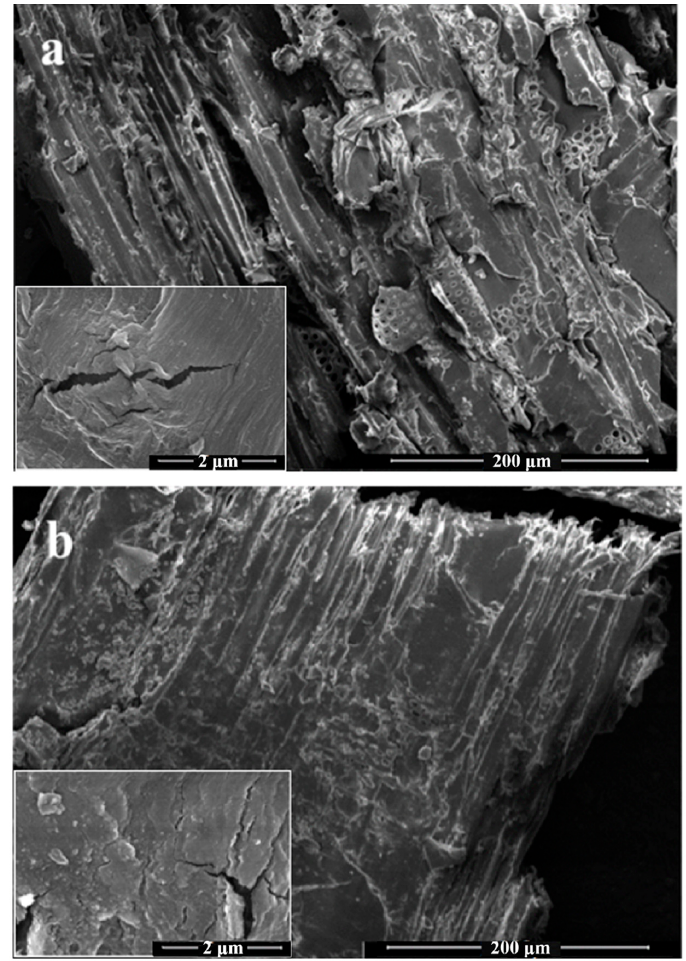
Figure 1. SEM images of raw sawdust ( a ) and SMSD ( b ).